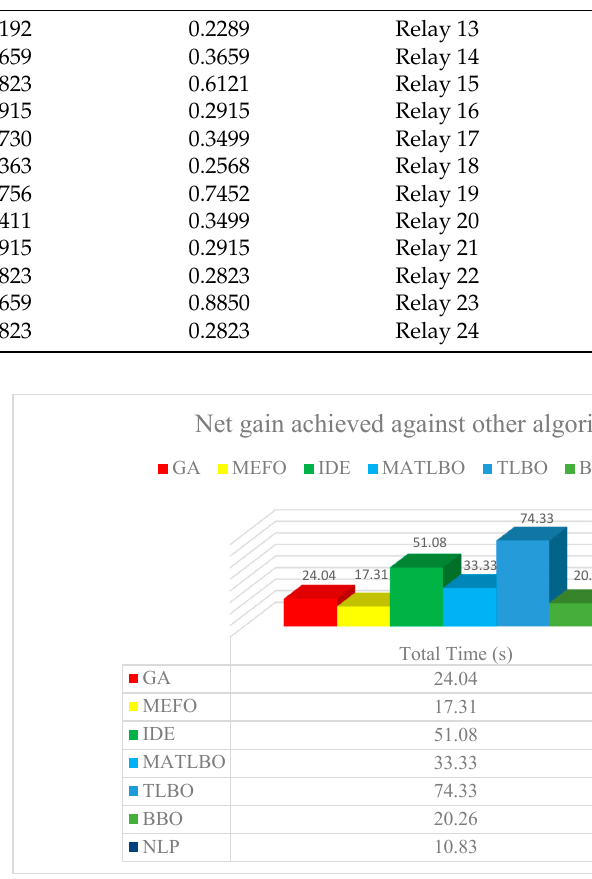
Figure 3. Analysis of net gain for the IEEE 9-Bus system.